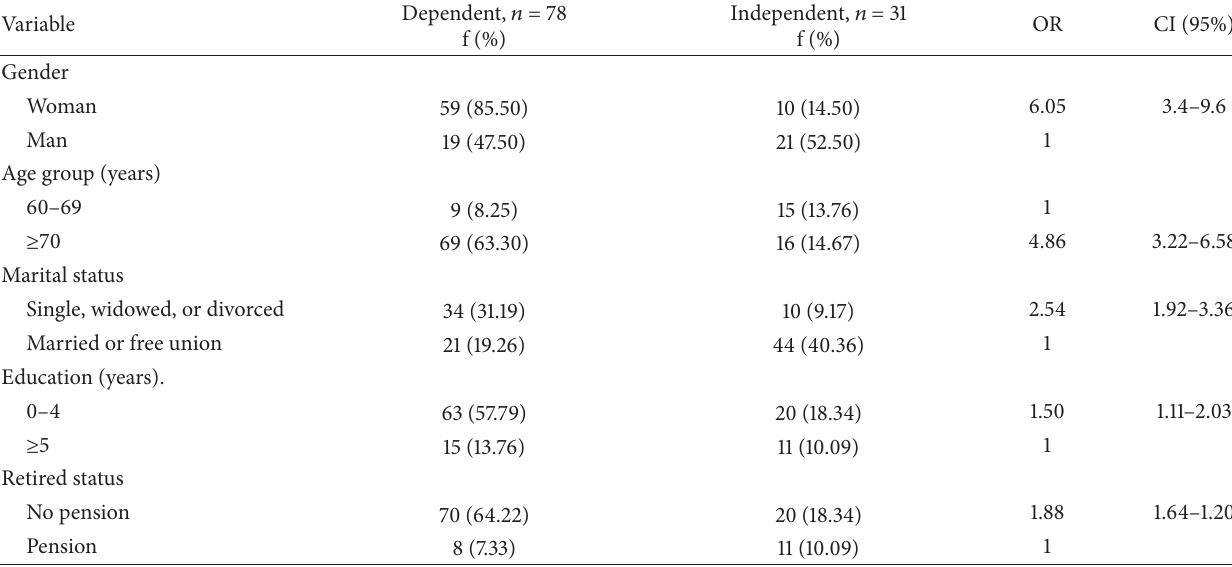
Table 4: Association between sociodemographic characteristics and dependency for activities of daily living ( 𝑛 = 109 older adults with